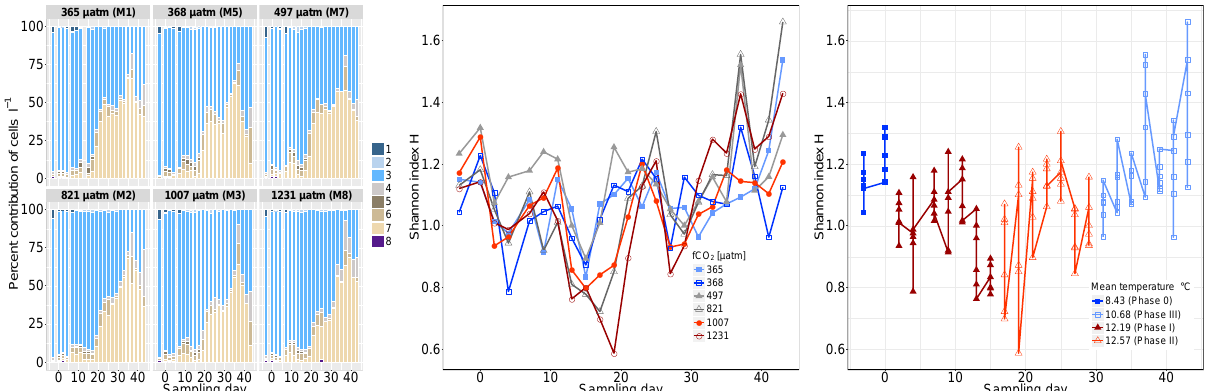
Figure 3. Left: percent contribution of abundance of major taxonomic species–genera–groups to the ciliate community. Numbers in the figure legend indicate: 1 = Balanion comatum , 2 = Mesodinium sp., 3 = Myrionecta rubra , 4 = Others , 5 = Spathidium sp., 6 = Strobilidium sp., 7 = Strombidium sp., 8 = Tintinnidae sp. Note that there is one missing value in M1 on t 13 . Middle: Ciliates, daily change of the Shannon diversity index H at the different f CO 2 levels in the mesocosms. Right: Ciliates, daily change of the Shannon diversity index H during the four different defined temperature phases. Color legend gives mean temperature during phase 0 (12.57 ◦ C), phase I (8.43 ◦ C), phase II (10.68 ◦ C), and phase III (12.19 ◦